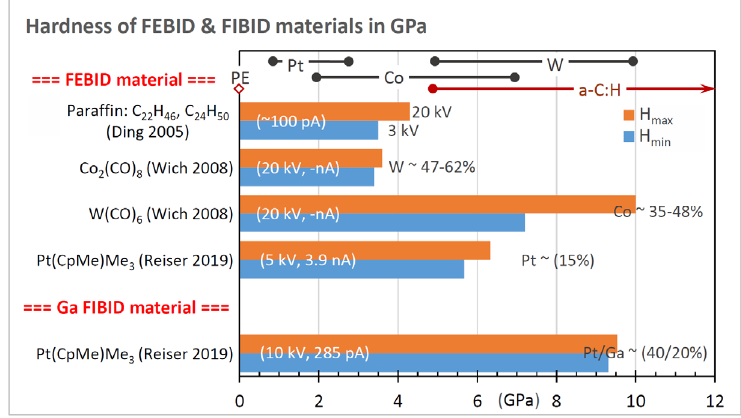
Figure 17. Elastic moduli of FEBID and FIBID material vs. reported metal content. ( a ) For Pt–carbon deposits. Composite elastic moduli according to the Hashin–Shtrikman upper and lower bounds are shown as lines. The corresponding numerical values represent fits to the data points. ( b ) Normalized elastic moduli of metal carbon materials from references indicated in the data legend. Stiffening due to e-beam curing is indicated by an orange dashed arrow. The additional gallium metal content for FIB deposits was not considered.